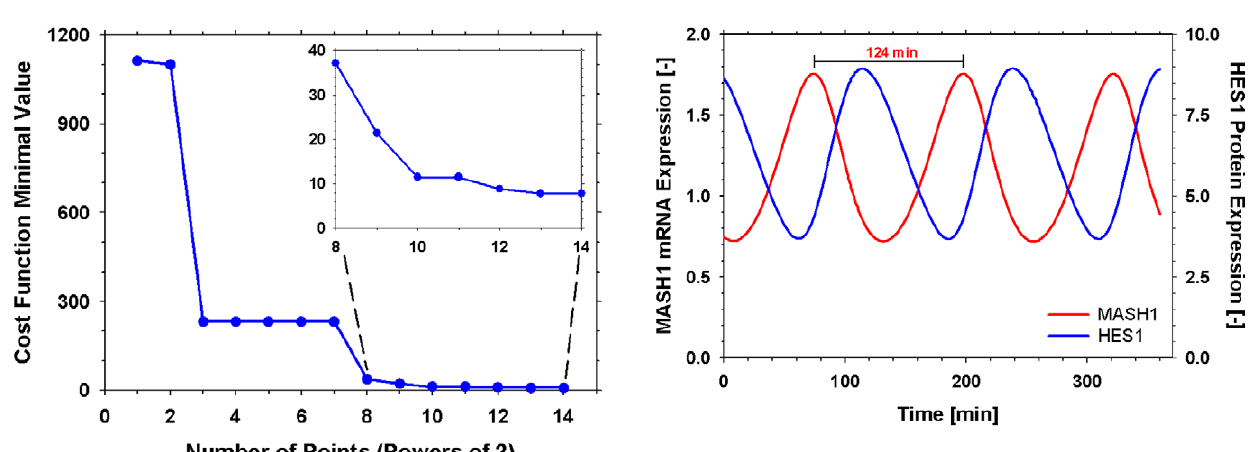
Figure 4. Oscillatory expression of Mash1 at steady state for non-differentiated cells using the optimal parameter values from Table 2. Oscillatory behaviour of the pathway with a period of 2.0h. Mash1 concentration peaks between the concentration peaks of its repressor Hes1.